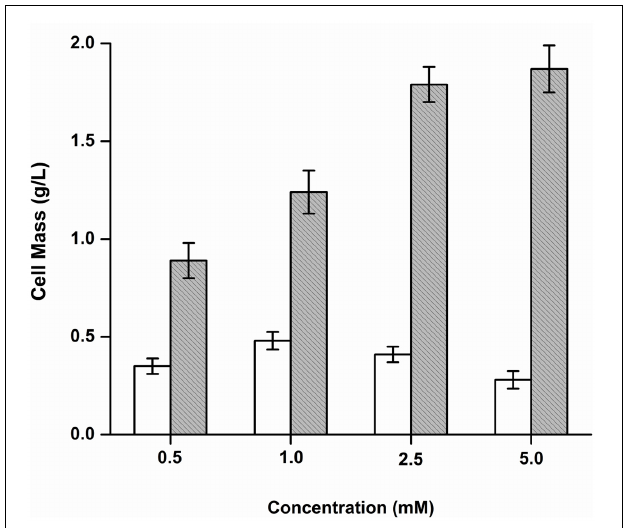
FIGURE 6 | Growth of Y. lipolytica on phenol and catechol. Increase in cell mass after growth on phenol ( ) and catechol ( ) was determined and plotted against different concentrations of the substrates.